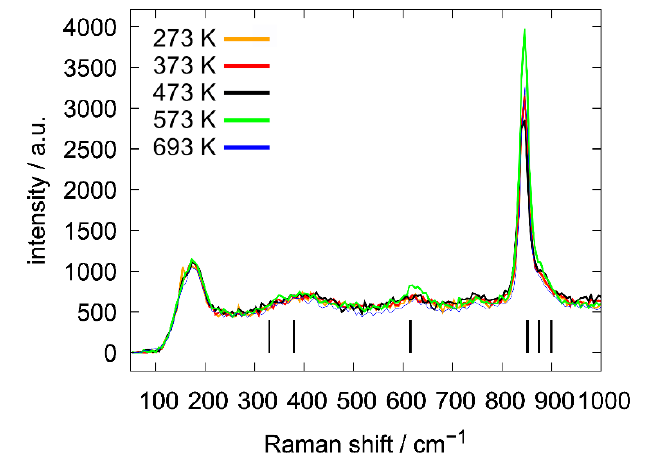
Figure 9. Raman spectra in between neutron measurements after cooling from the mentioned tem- peratures to room temperature at E6; the black marker show the peak positions of Ba 2 In 1.8 Cr 0.2 O 5.3 (H 2 O) x according to Yoon et al. [3]. The heating and cooling were carried out in am- bient